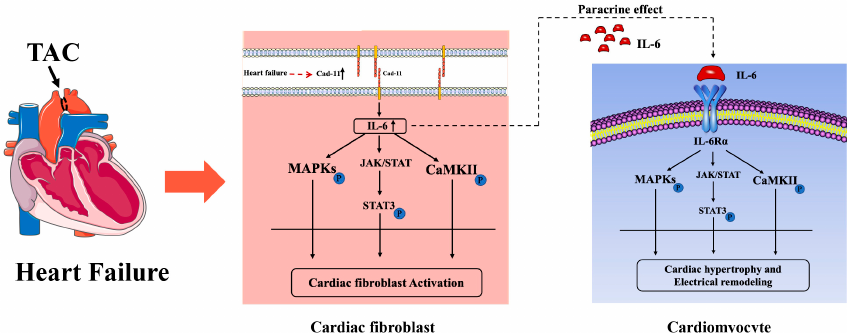
Figure 9. Model illustrating that Cad-11-IL-6 signaling pathway mediated cardiac fibrosis and myocardial hypertrophy in TAC-Induced Heart Failure.